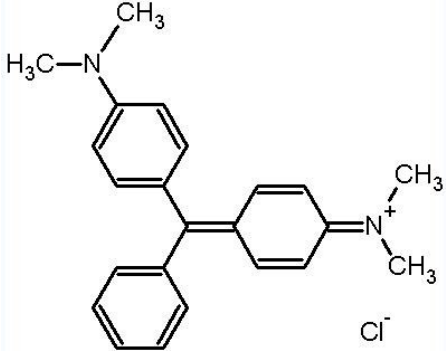
Figure 1. Structure of Malachite Green.